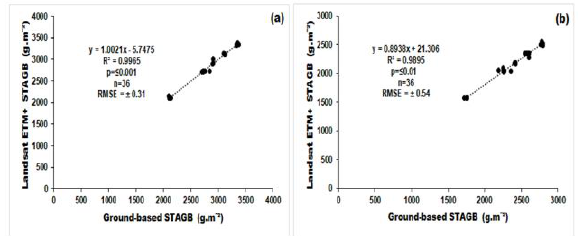
Figure 5. The in-situ-based seagrass biomass versus satellite- based estimation in the corresponding point locations using 36 inductive sites as well as 36 deductive sites.